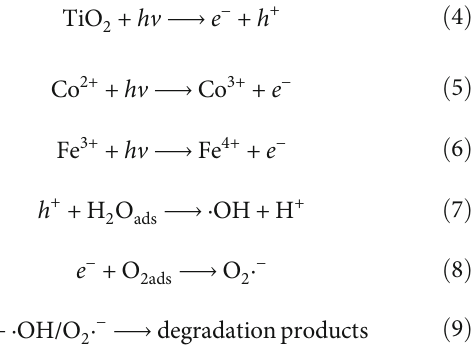
and TiO codoped with Co 2+ 2 2